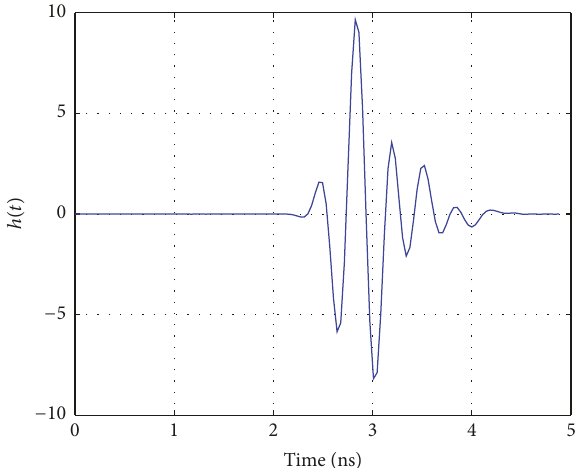
Figure 11: Impulse response of the single band CPW antenna.